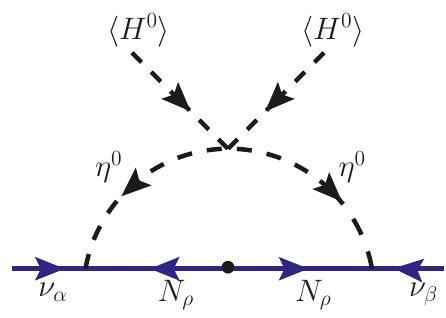
Figure 57 . Neutrino mass generation at one-loop in the scotogenic model